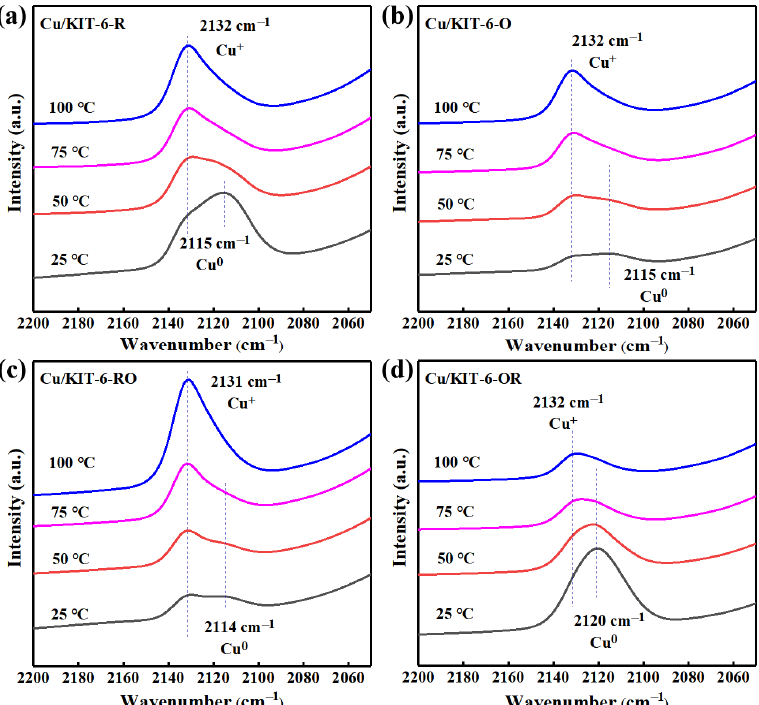
Figure 8. DRIFTS analysis of sequential adsorbed CO over the Cu/KIT-6 catalyst under different pre-treatment atmospheres: ( a ) R, ( b ) O, ( c ) RO, and ( d ) OR samples.